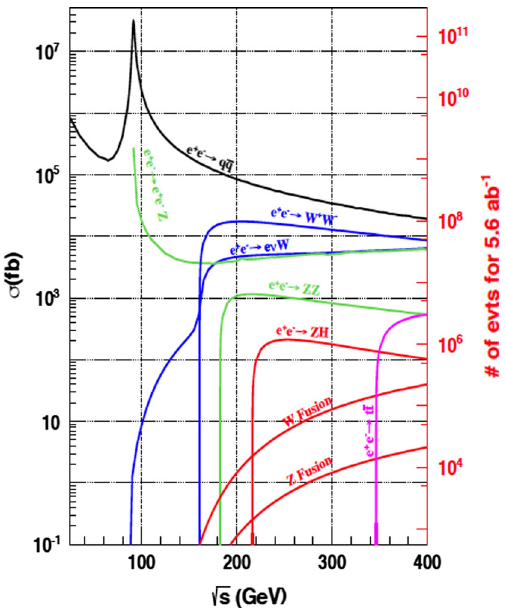
Fig. 1 The cross section for unpolarized e + e − collision, the right side shows the expected number of events at the nominal parameters of the CEPC Higgs runs at 240 GeV center-of-mass energy [1]